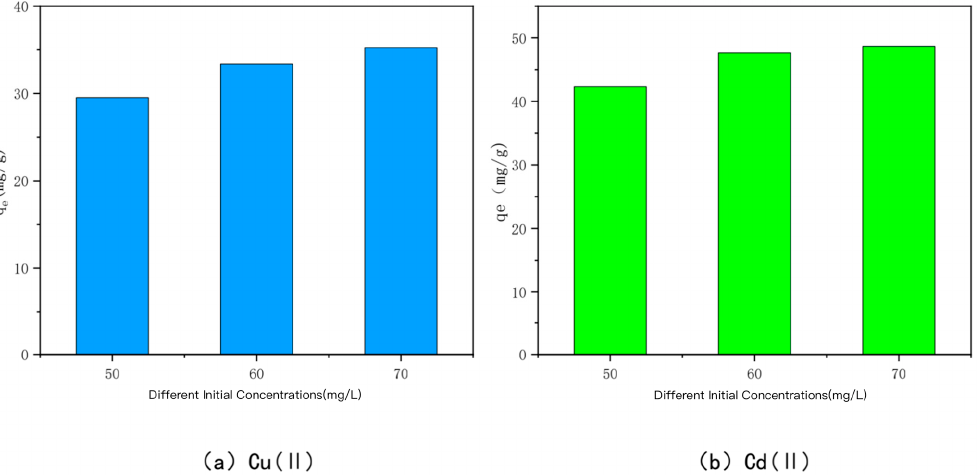
Figure 8. Effect of different initial concentrations on the adsorption of Cu(II /Cd(II) by KAM500-400-3.